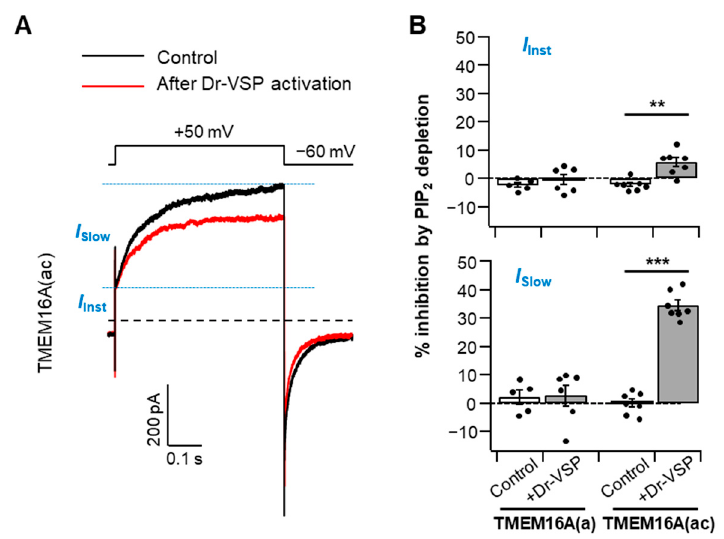
Figure 2. Analysis of PI(4,5)P 2 regulation regarding the two steps of TMEM16A activation. ( A ) Representative Cl − current traces activated by a voltage step to +50 mV before (control) and after Dr-VSP activation in cells expressing TMEM16A(ac) in the presence of a 115 nM intracellular Ca 2+ concentration. Black trace: control (before Dr-VSP activation). Red trace: after Dr-VSP activation. The dotted line indicates zero current. The horizontal dashed lines (blue) indicate the separation point for the instantaneous and slow currents. I Inst —instantaneous Cl − current; I Slow —slow Cl − current. ( B ) Inhibition (%) of the instantaneous (top) and slow (bottom) currents in response to PI(4,5)P 2 depletion by Dr-VSP activation in cells expressing TMEM16A(a) or TMEM16A(ac); n = 5–7. Dots indicate the individual data points for each cell. Bars indicate means ± SEM. ** p < 0.01, *** p < 0.001, one-way ANOVA followed by Sidak’s post hoc test.